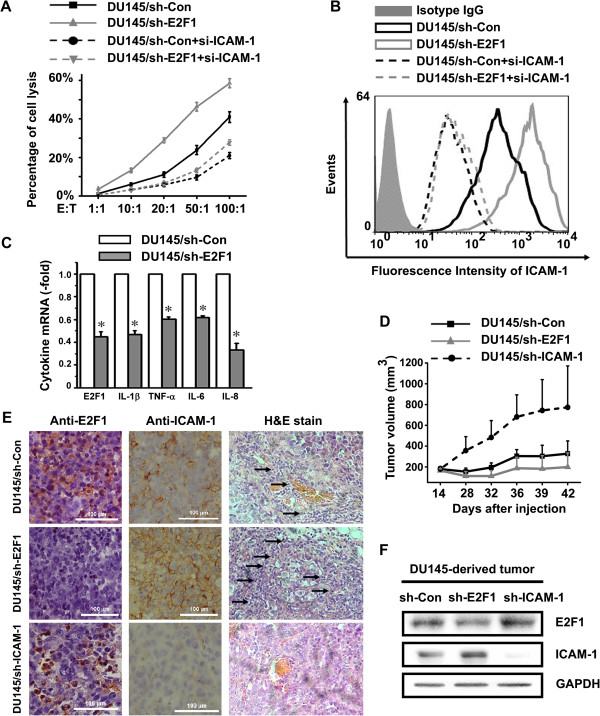
RNA Silencing of E2F1 Sensitizes Prostate Cancer Cells to ICAM-1 Mediated Anti-tumor Responses. A. E2F1 knockdown increases cytotoxicity through ICAM-1. DU145/sh-Con and DU145/sh-E2F1 cells were transiently transfected with duplex siRNA of ICAM-1. The DU145 derived cells were used as the target cells and the CIK cells as the effector cells. Both of them at various ratios of effector cells to target cells were mixed and cytotoxicity was measured by 51Cr release. The results are shown as the mean ± SD of triplicate measurements. B. The expression of membrane ICAM-1 in the indicated cells was measured by FACS with ICAM-1 specific antibody. C. The expression of IL-1β, TNF-α, IL-6 and IL-8 in DU145/sh-Con and DU145/sh-E2F1 cells were measured by real-time PCR. The data presents the fold-induction of the levels of each tested cytokine in DU145/sh-E2F1 cells over DU145/sh-Con cell, and represent the mean ± SD of triplicate measurements. D. E2F1 knockdown inhibits tumor xenografts growth in vivo, DU145 cells were stably transfected with the control vectors or shRNA expressing plasmids targeting E2F1 or ICAM-1 respectively and injected subcutaneously into nude mice. Tumor volumes were measured and estimated by the formula: length (mm) X width (mm) X height (mm)/2. The results are shown as the mean value ± SD of at least five tumors in each group. E and F. E2F1 knockdown increases ICAM-1-mediated leucocytes infiltration. The infiltrating leucocytes to DU145-derived tumors in nude mice were stained by H&E and indicated by arrows. The expression of E2F1 and ICAM-1 in these DU145-derived tumors was monitored by immunohistochemistry analysis, H&E staining (D) and Western blot (E).